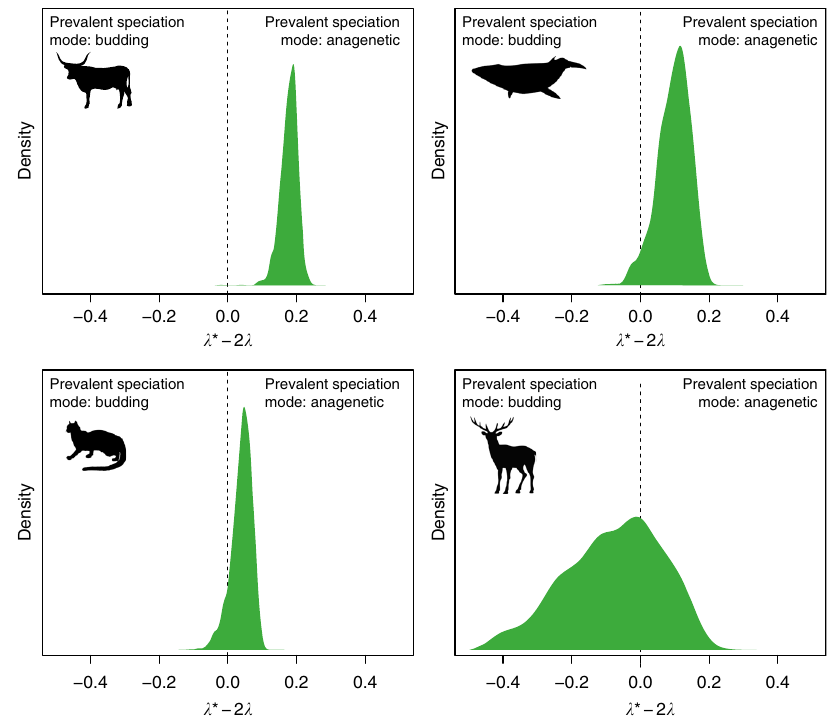
Fig. 4 Prevalent mode of speciation inferred under the BDC model. Although the exact contribution of different speciation modes cannot be quanti fi ed under the BDC model, the joint analysis of fossil and phylogenetic data is informative about the relative importance of budding versus anagenetic speciation. The four clades shown here (Bovidae, Cetacea, Feliformia, Cervidae) show support for diversi fi cation under the compatible rates model, meaning stratigraphic and phylogenetic estimates of speciation and extinction rates are different, but can be explained by differences in speciation mode (Fig. 3). Based on the properties of the BDC model, positive values of λ * − 2 λ (posterior distributions from a joint Bayesian analysis shown as density plots) indicate that the rate of anagenetic speciation exceeds the rate of budding speciation, whereas the opposite is true for negative